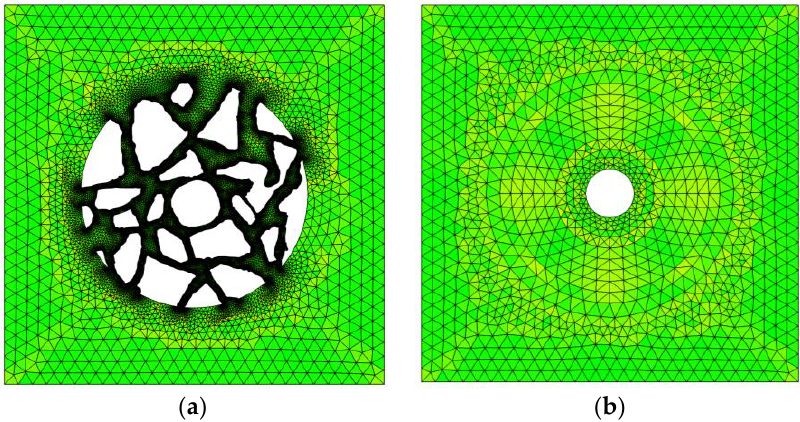
Figure 2. 2 D mesh used in numerical calculations of ( a ) cement and ( b ) mortar cylinder-shaped Figure 2. 2D mesh used in numerical calculations of ( a ) cement and ( b ) mortar cylinder‑shaped samples immersed in an aqueous solution. samples immersed in an aqueous